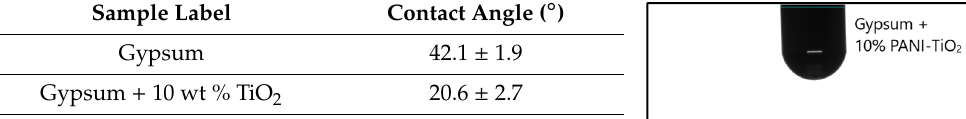
Table 3. The contact angle analysis for gypsum and gypsum modified with TiO 2 or PANI–TiO 2 .